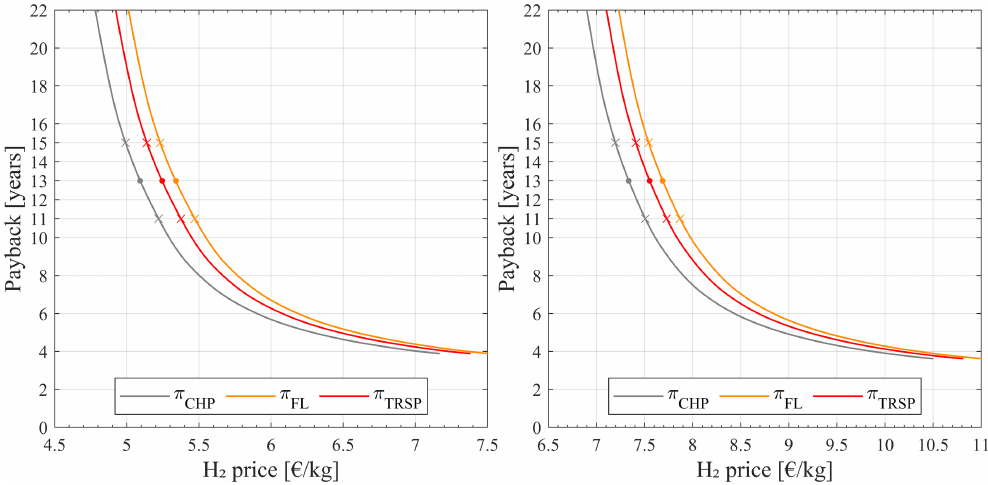
Figure 3. Grey scenarios—relation between payback period and H 2 price for each customer for scenario Grey17–20 ( left ) and Grey21 ( right ).